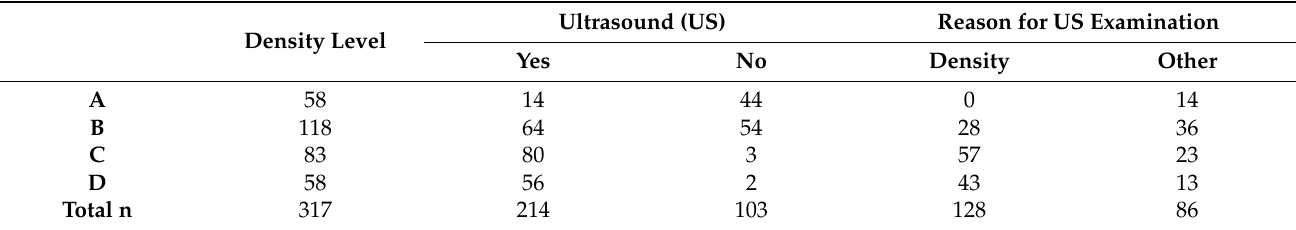
Table 2. Patient overview regarding breast density distribution and ultrasound examinations, with n describing the total number of